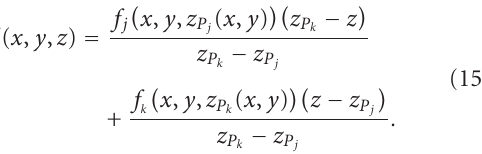
gans include lungs, heart, aorta, ribs, spine, sternum,